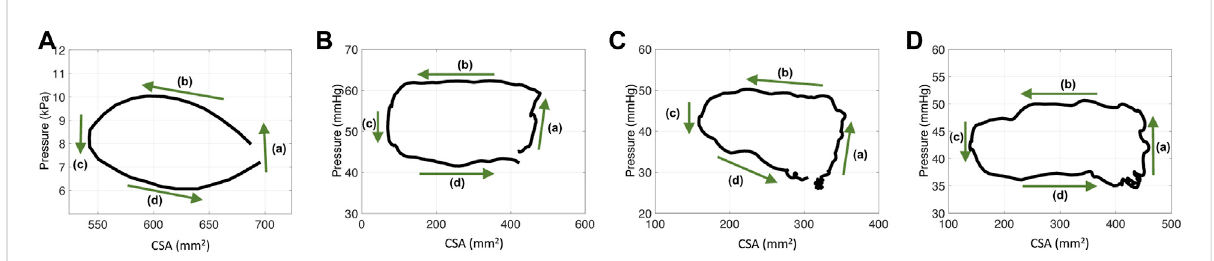
FIGURE 2 P-CSA relationships in the esophagus body for four different contraction cycles with different experimental setups. (A) P-CSA extracted from a 4-cmlong FLIPobtained byGregersenetal. (2011). (B) and (C) P-CSA extracted froma16-cm longFLIPat60 ml,where theFLIPbagpassesthrough the LES. These hystereses are plotted from data recorded at a sensor located away from the LES. (D) P-CSA extracted from a 16-cm long FLIP at 60 ml, where the FLIP bag does not cross the